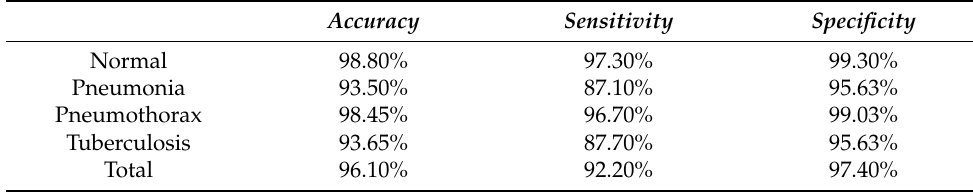
Table 13. Test Performance.